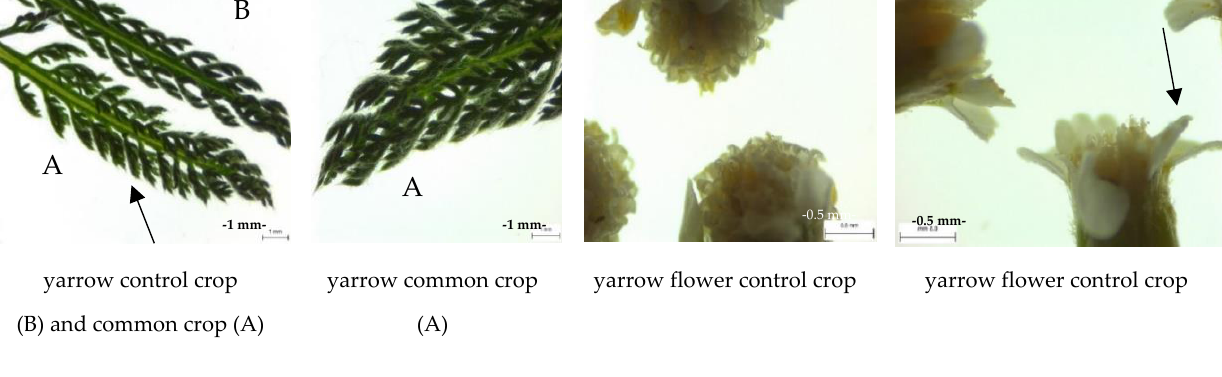
Figure 14. Yarrow.